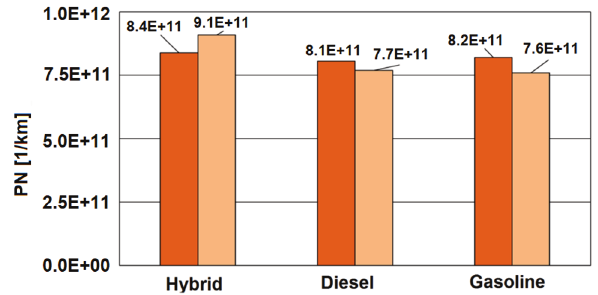
Fig. 18. Particle number emission for each of the vehicles in the whole RDE test (EMROAD and all data)